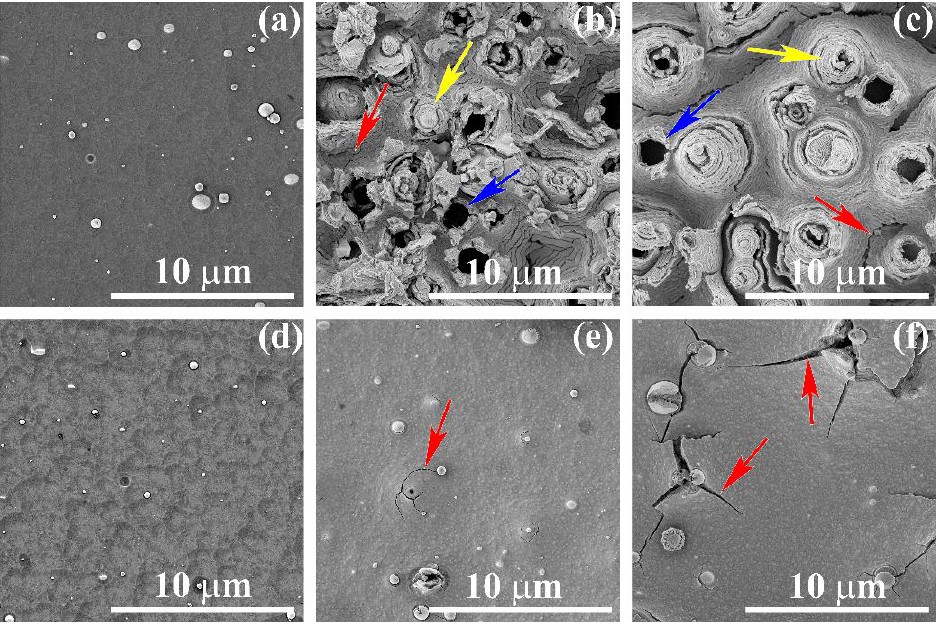
Figure 6. SEM SE images of 0.5 RPM ( a – c ) and 8 RPM ( d – f ) multilayer coatings oxidized at 300 ( a , d ), 600 ( b , e ) and 700 °C ( c , f ). Yellow, blue and red arrows denote cracked blisters, craters and cracks, respectively.